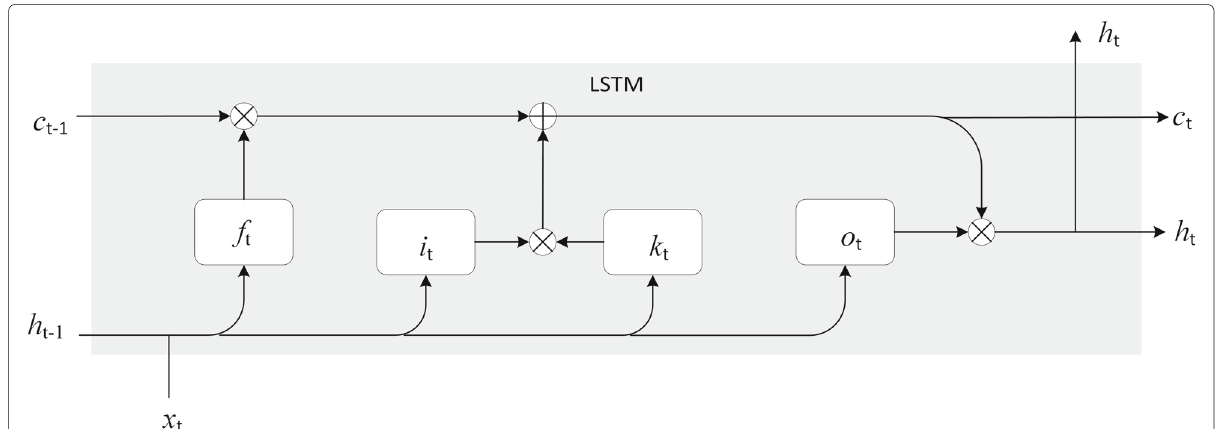
Fig. 2 LSTM block at step t with information gate i t , forget gate f t , output gate o t , and cell gate c